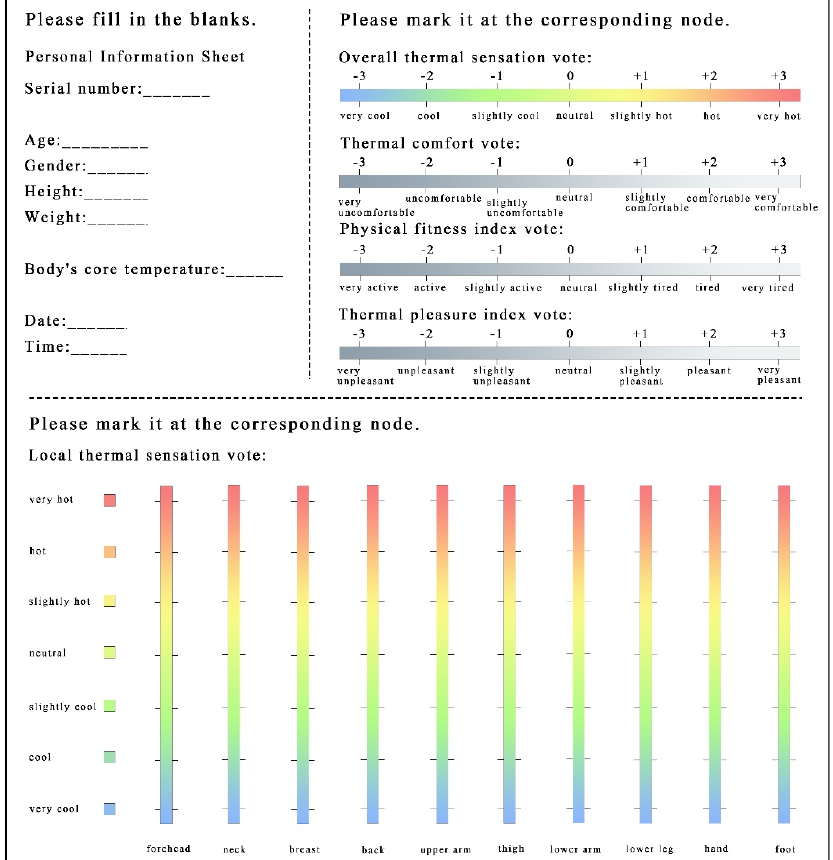
Figure 4. Questionnaire used for each participant in the experiment.